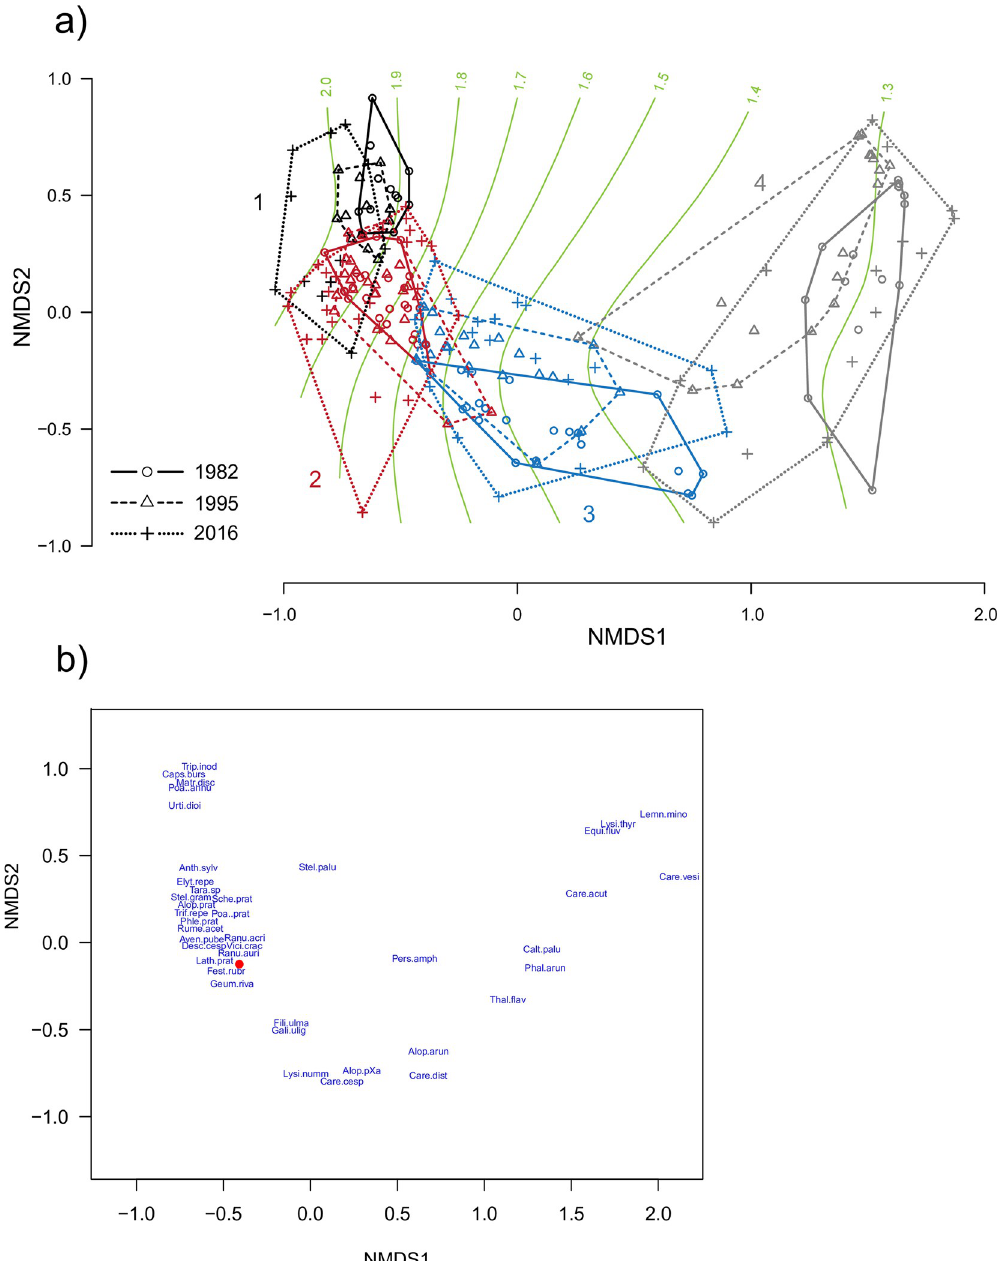
Fig 5. (a) NMDS ordination of plots in Profiles 1–4 on Kungsa¨ngen in 1982, 1995 and 2016. The plots are allocated among four clusters based on the vegetation in 1982 ( n = 76). These clusters are identified by colours. The three survey years are identified by symbols and line types. NMDS stress = 0.07. The green lines are fitted elevation contours (m a.s.l.). (b) Species ordination, showing the six most abundant species in each envelope and other representative species that are mentioned in the text (such as ruderals). The red dot is Fritillaria meleagris . Some species positions are slightly shifted to reduce text overlap. For full species names, see S2